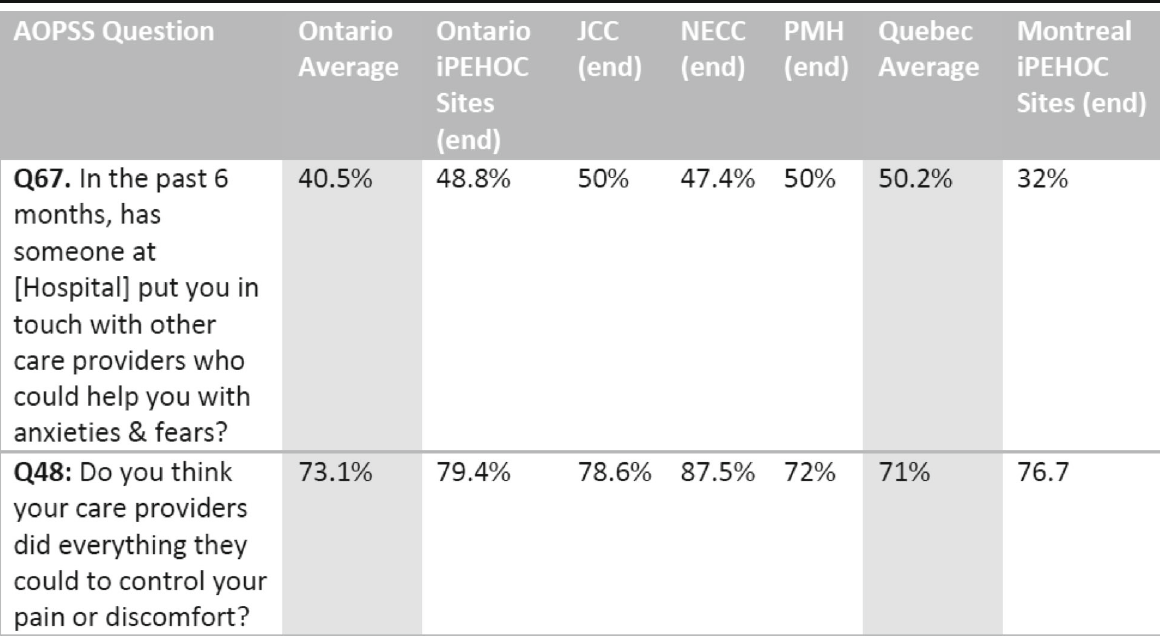
Table 2 Patient Experience Compared to Provincial Standards-2